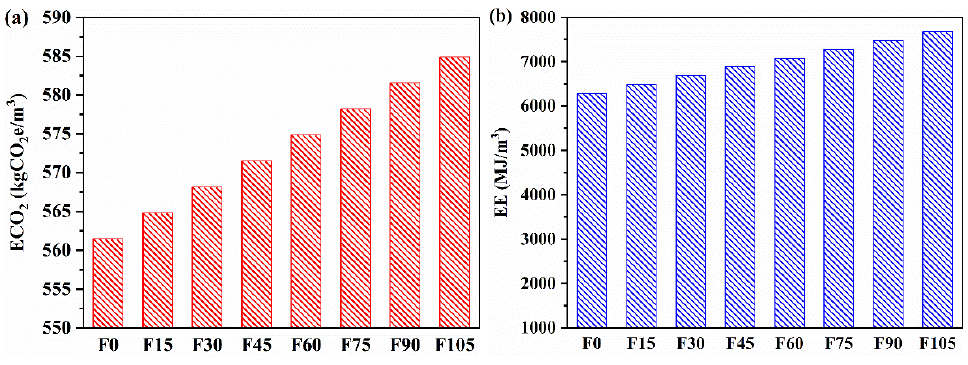
Figure 14. ECO 2 e ( a ) and EE ( b ) of F15–F105.